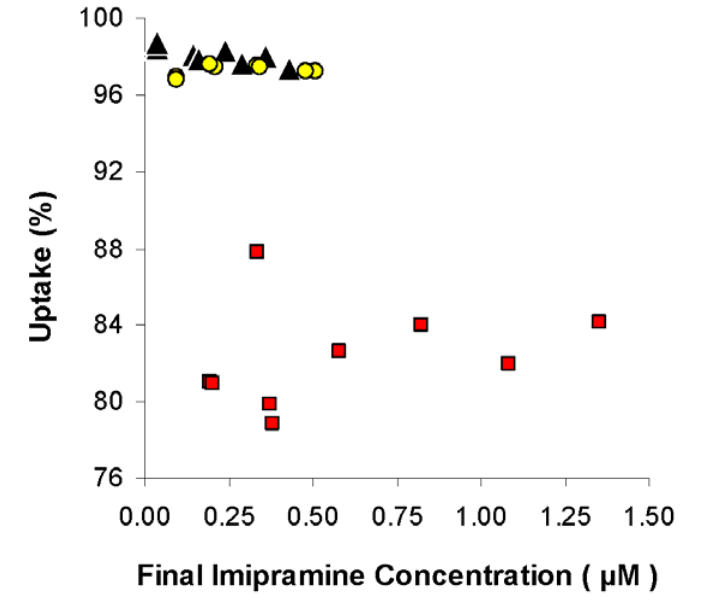
Figure 5. Percent imipramine uptake by human serum ( ) and by a mixture of human serum and 95:5 DOPG:DPPE-mPEG-2000 liposomes at 1.44 mg lipid/mL ( ▲ ) and a mixture of human serum and 95:5 DOPG:DPPE-mPEG-5000 liposomes at 1.68 mg lipid/mL ( ) versus final imipramine concentration. Figure adapted from [44].